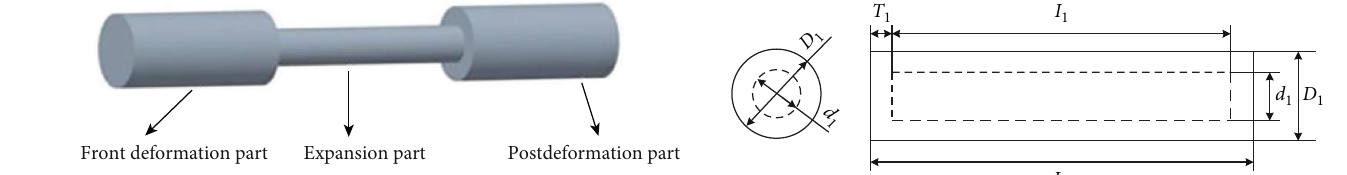
F IGURE 1: Schematic diagram of the pipe soft robot.